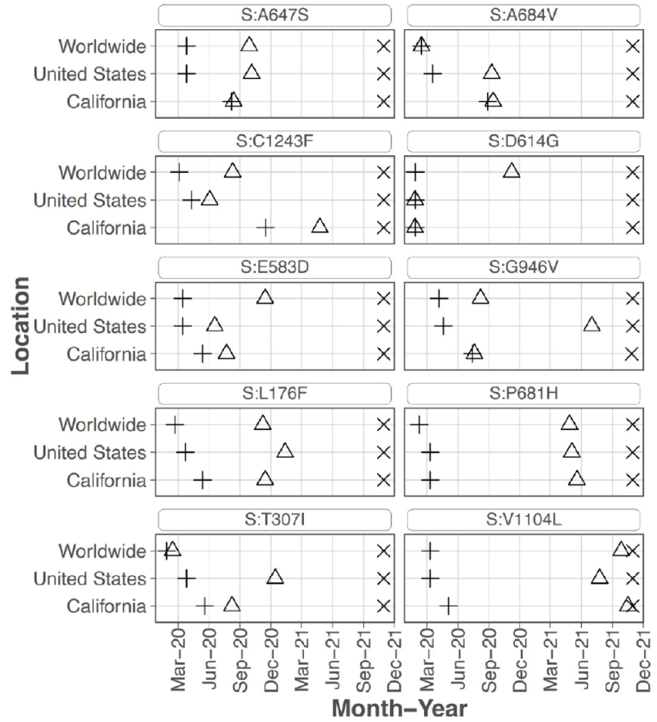
Figure 4. Emergence, peak and duration of highest ranked spike mutations. Graphs show for each highest ranked mutation the date the mutation was detected, the date it reached peak prevalence, and the date last detected. Mutations are considered to be persistent when they are still detected in November 2021, the latest date sequence data available through outbreak.info were analyzed for this study.